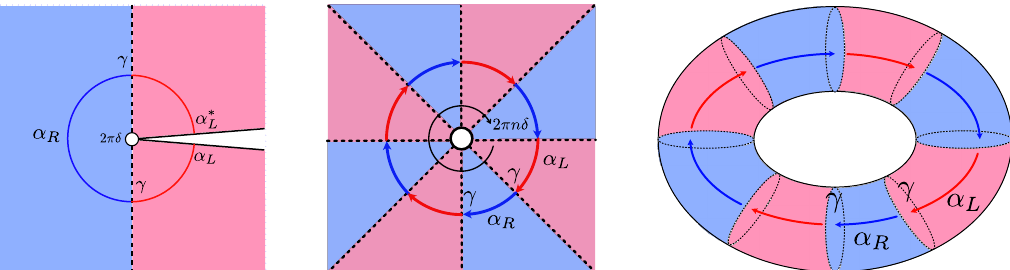
Figure 10 . (Left) A cartoon of reduced density matrix with the tubular neighborhood removed. (Middle) The replica geometry; the mutual intersection of the interfaces has been regulated. (Right) The geometry after mapping to S 1 D 2 . The Wilson threads this solid torus, intersecting the (cid:2) interfaces